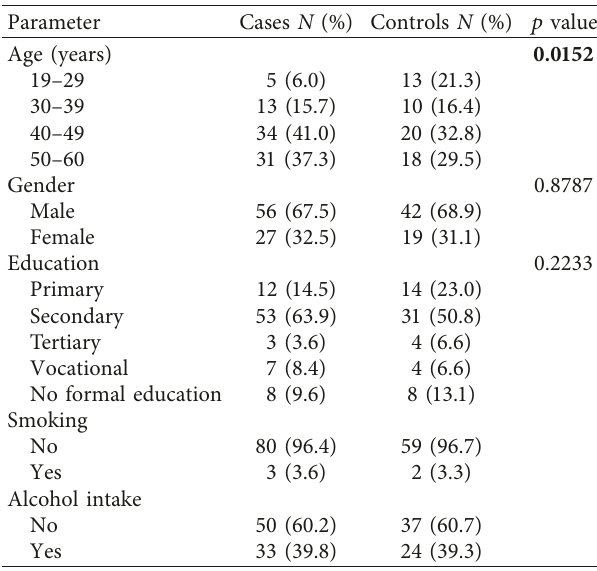
Table 1: Demographic details of participants.